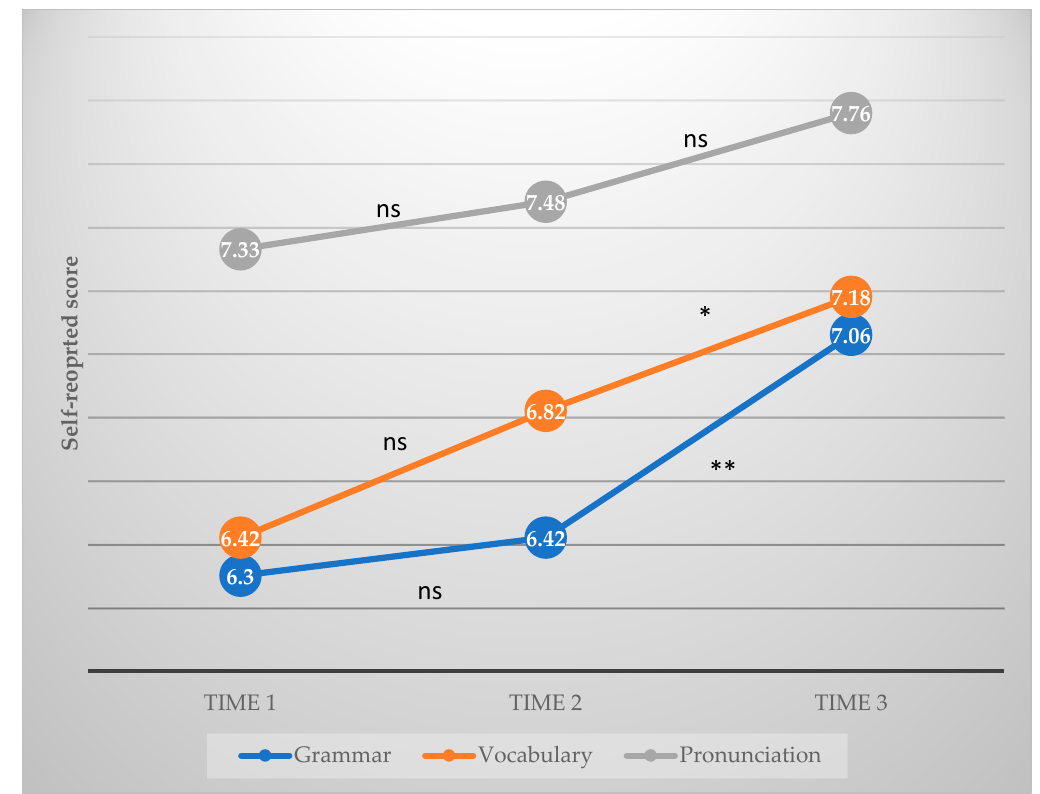
Figure 6. Mean scores for self-reported proficiency in the three domains at Times 1, 2, and 3 (* p < 0.05, ** p < 0.01).